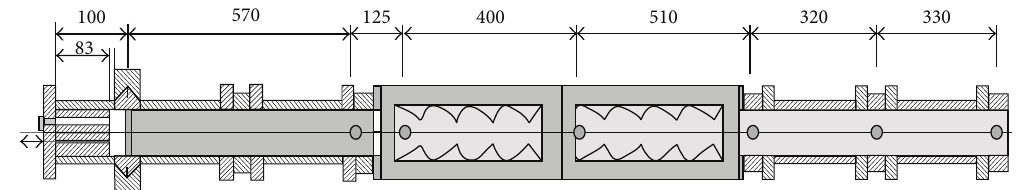
Figure 9: Scheme view of experimental unit with profiled regular obstacles [36].